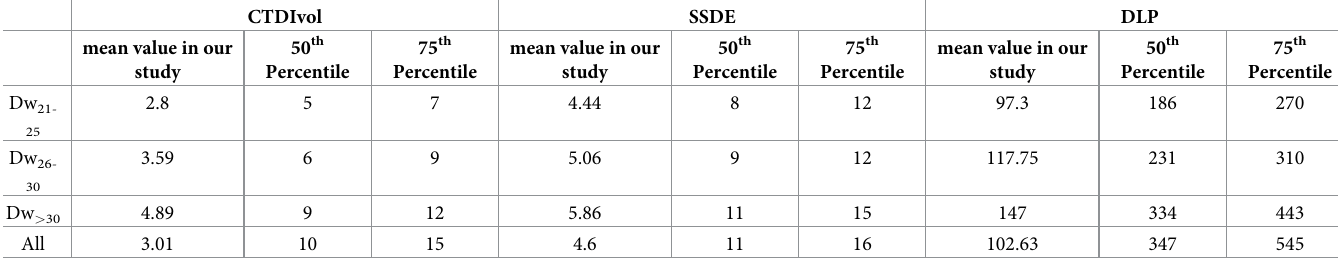
tantly, DRLs are established regionally and nationally, which are dose distribution derived from a survey conducted on a wide user base (including large, small, public, private, hospital, and outpatient facilities) and different manufacturers and models of equipment, and varied extensively among regions and countries [29,30]. Our institution is located at the southwest part of China, where the majority of the patient population has body sizes less than national